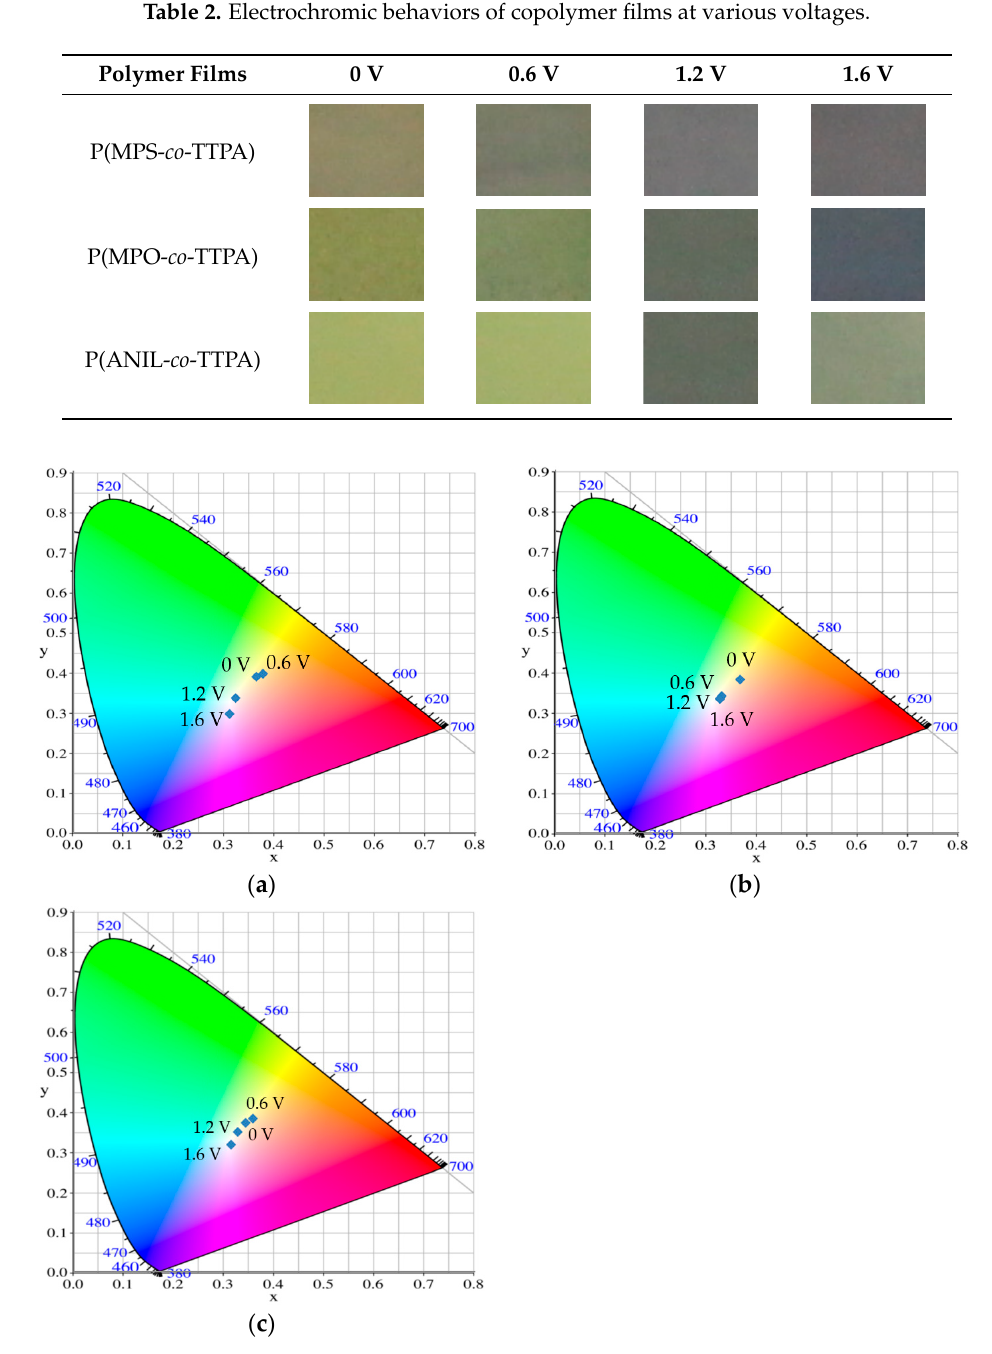
Figure 6. CIE chromaticity diagrams of ( a ) P(MPS- co -TTPA); ( b ) P(MPO- co -TTPA); and ( c ) P(ANIL- co -TTPA) films in neutral and oxidation states.